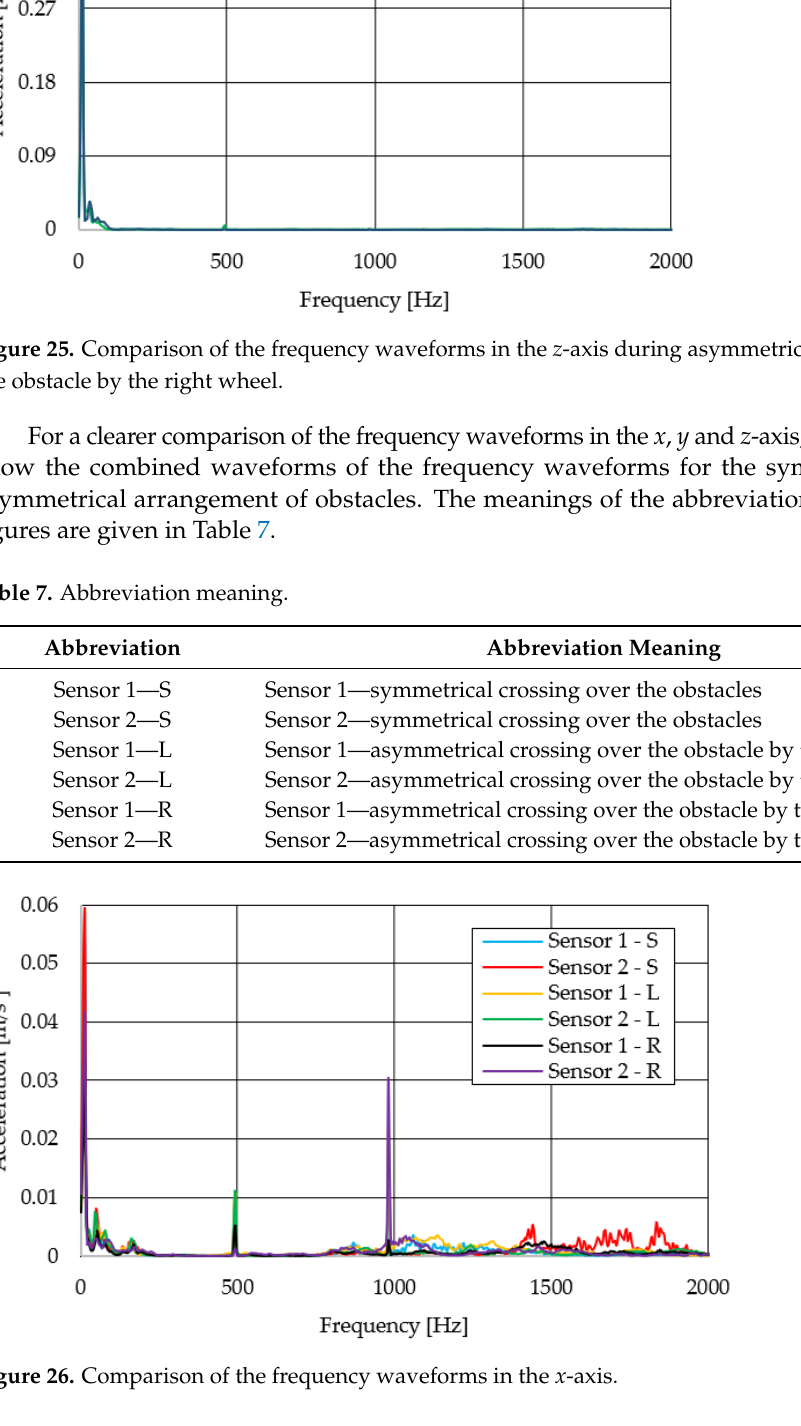
Figure 27. Comparison of the frequency waveforms in the y -axis. Figure 28. Comparison of the frequency waveforms in the z -axis.